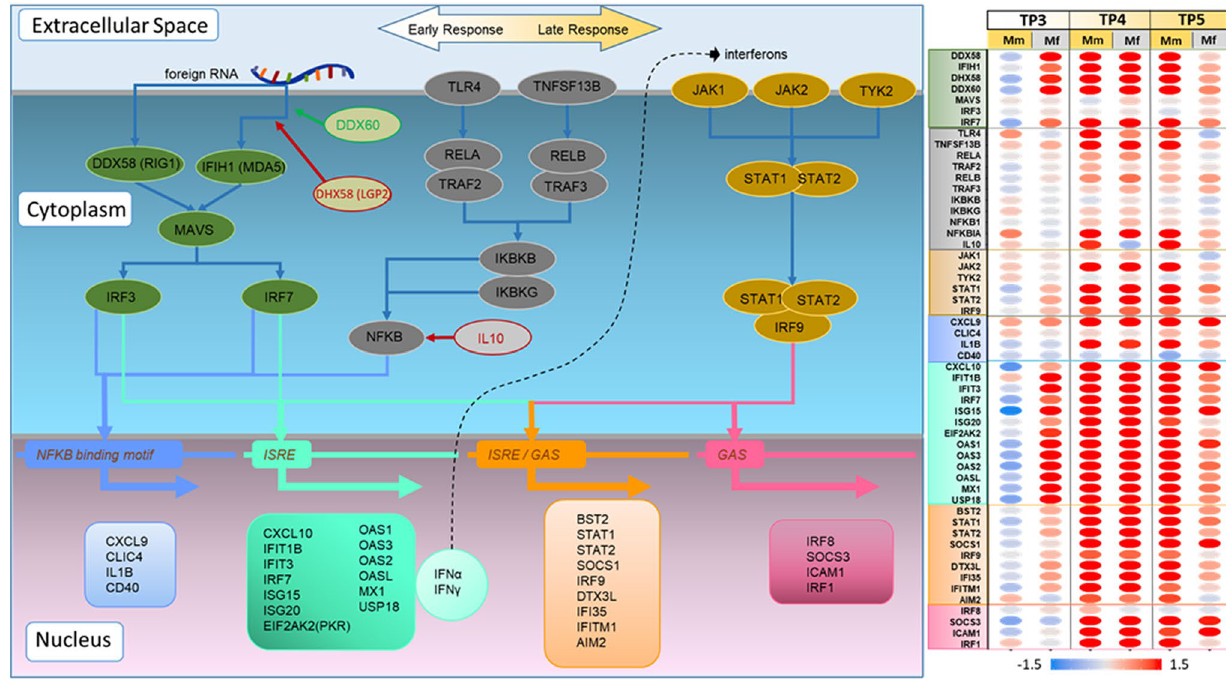
Figure 6. Transcription factors and associated genes of signaling pathways during the immune response. The TFs and genes shown are associated with differences in DEGs between early and late responses to infection. DEGs and their magnitudes are shown on the right for TP3, TP4, and TP5, with columns for each of Mm and Mf. Red dots signify up-regulation and blue dots down-regulation. In addition to DEGs at TP4 and TP5, the RIG1/MDA5-mediated PRR signaling pathway is included, as it is significantly different at TP3. IRF7- regulated genes expressed by ISRE also show significant changes. Finally, NFκB signaling, mediated by REL and RELA, plays a crucial role in controlling inflammation, and the ongoing strongly differential expression of the corresponding genes (ISRE- and GAS-regulated) at TP5 in Mm suggests a prolonged inflammatory response.